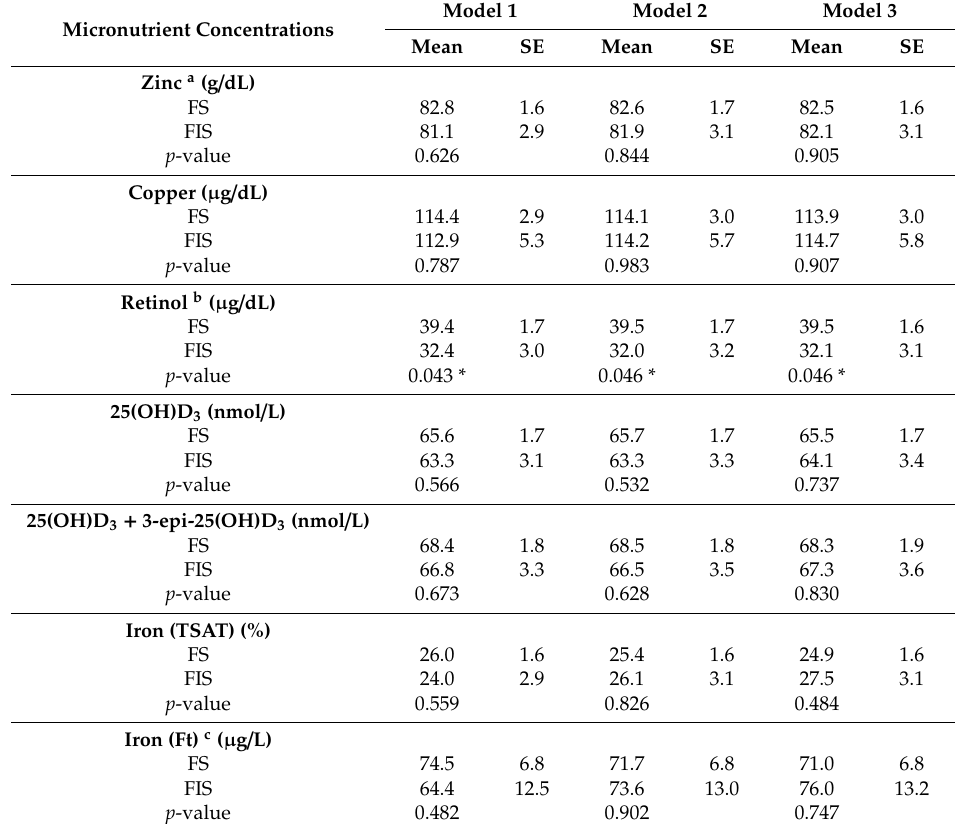
Table 2. Mean and standard error (SE) of micronutrient concentrations among Ghanaian women expecting to become pregnant in food secure and food insecure